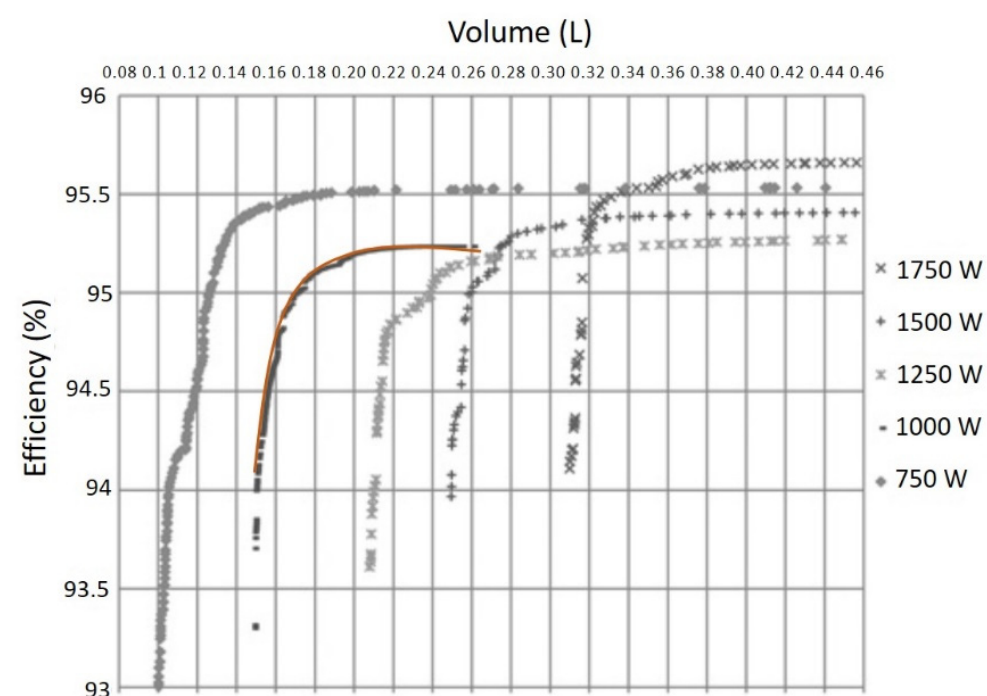
Figure 2. Discrete Pareto front of a DC-DC Interleaved Buck Converter obtained with a stochastic NSGA-II algorithm. Reprinted and adapted with permission from Larouci, C., 2022, Ref. [5].